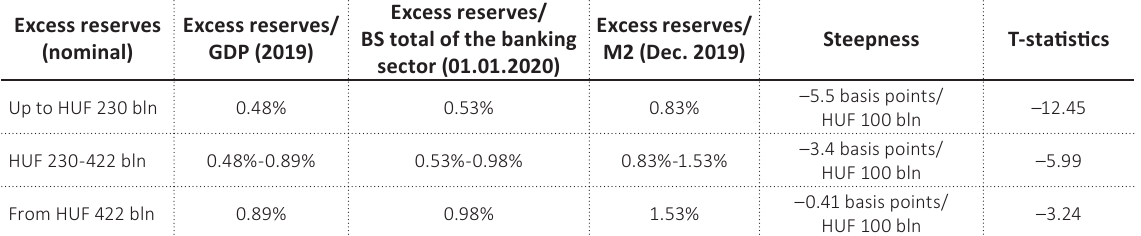
Table 5. Comparative data of the Hungarian and the US banking system and market for liquidity